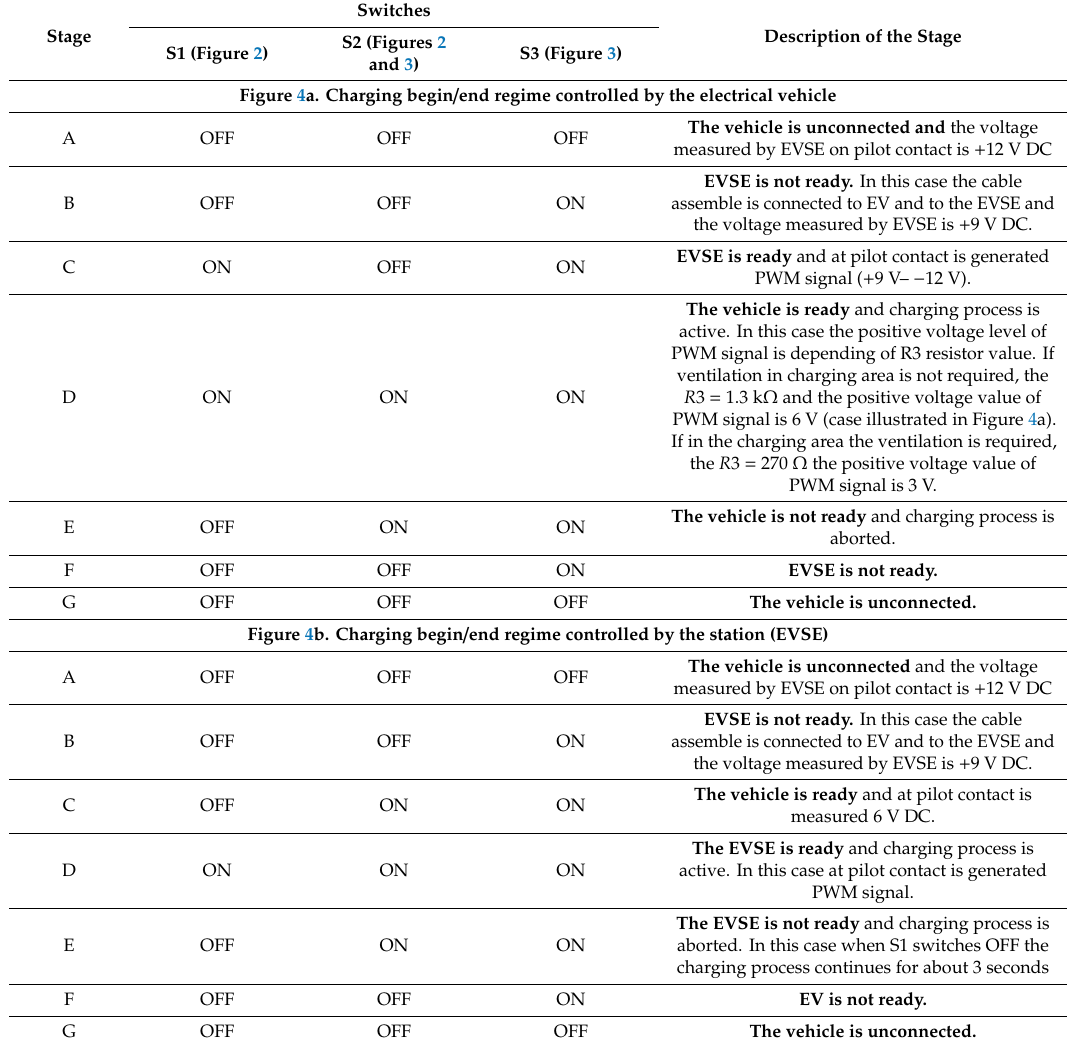
Figure 4a. Charging begin / end regime controlled by the electrical vehicle